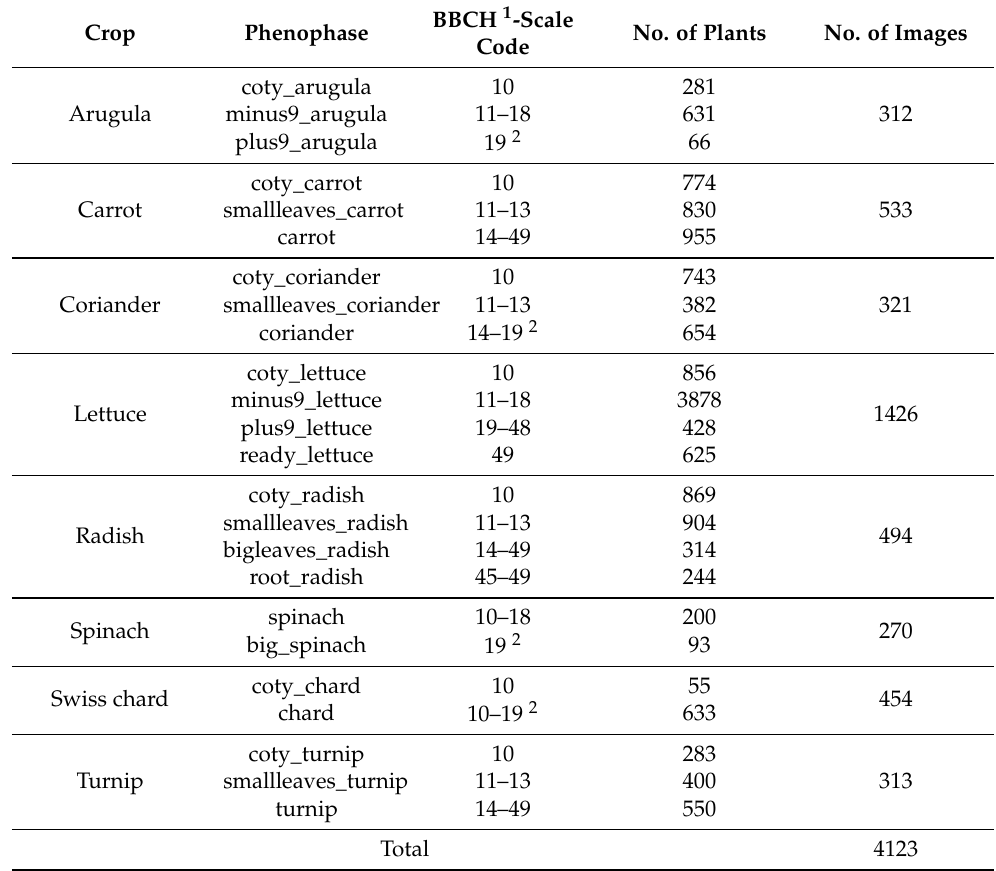
Table 2. Number of images acquired for each crop and the corresponding number of plants for each phenophase defined.